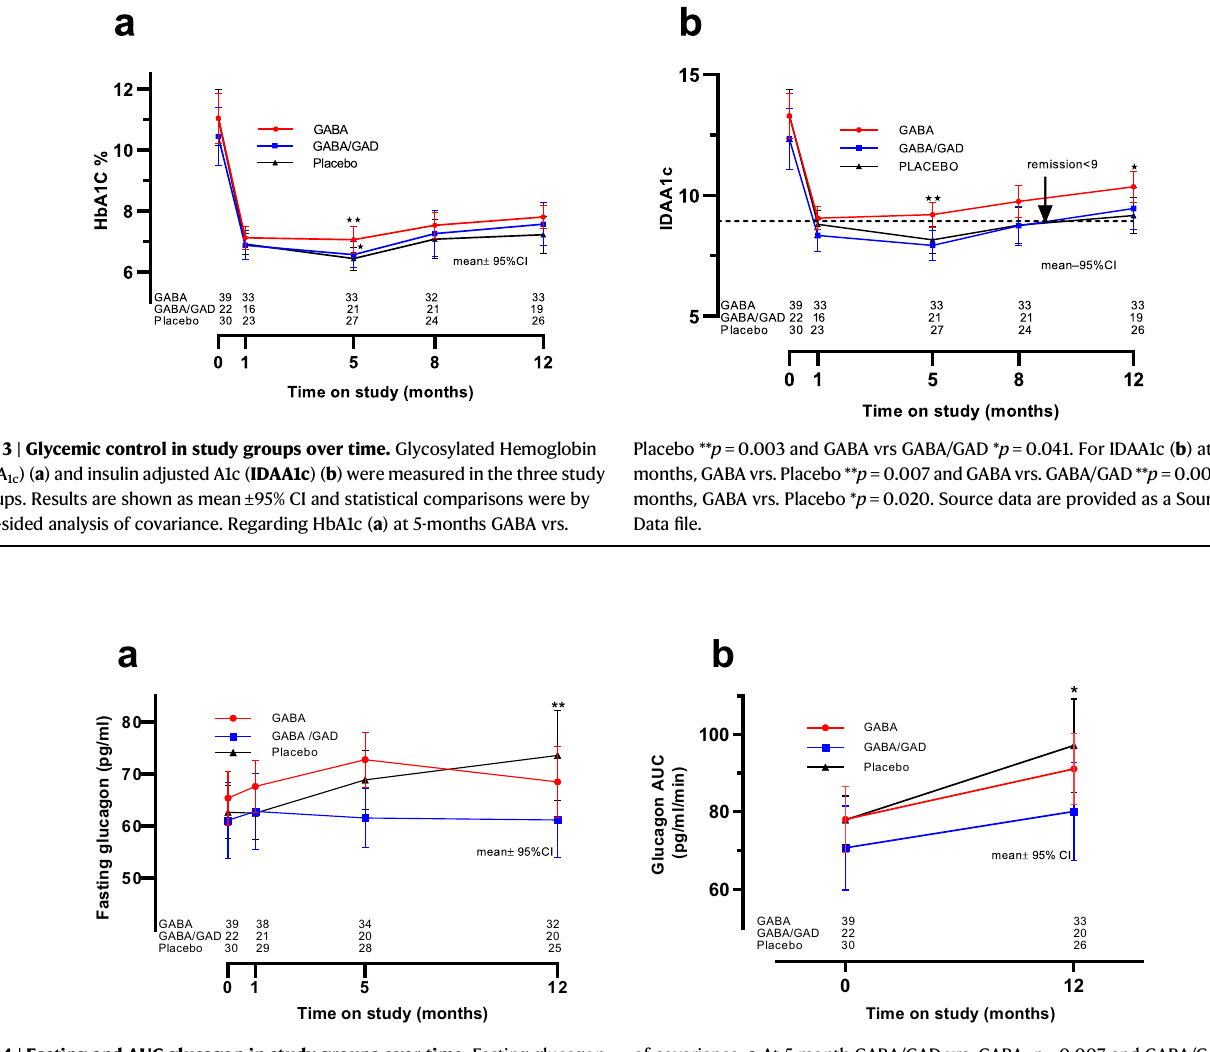
of covariance. a At 5 month GABA/GAD vrs. GABA, p =0.007 and GABA/GAD vrs. Placebo, p =0.086. At 12- months, GABA/GAD vrs. Placebo,** p =0.035. Regarding AUCglucagon( b ),at12-monthsGABA/GADvrs.Placebo,* p =0.041.Sourcedataare provided as a Source Data fi